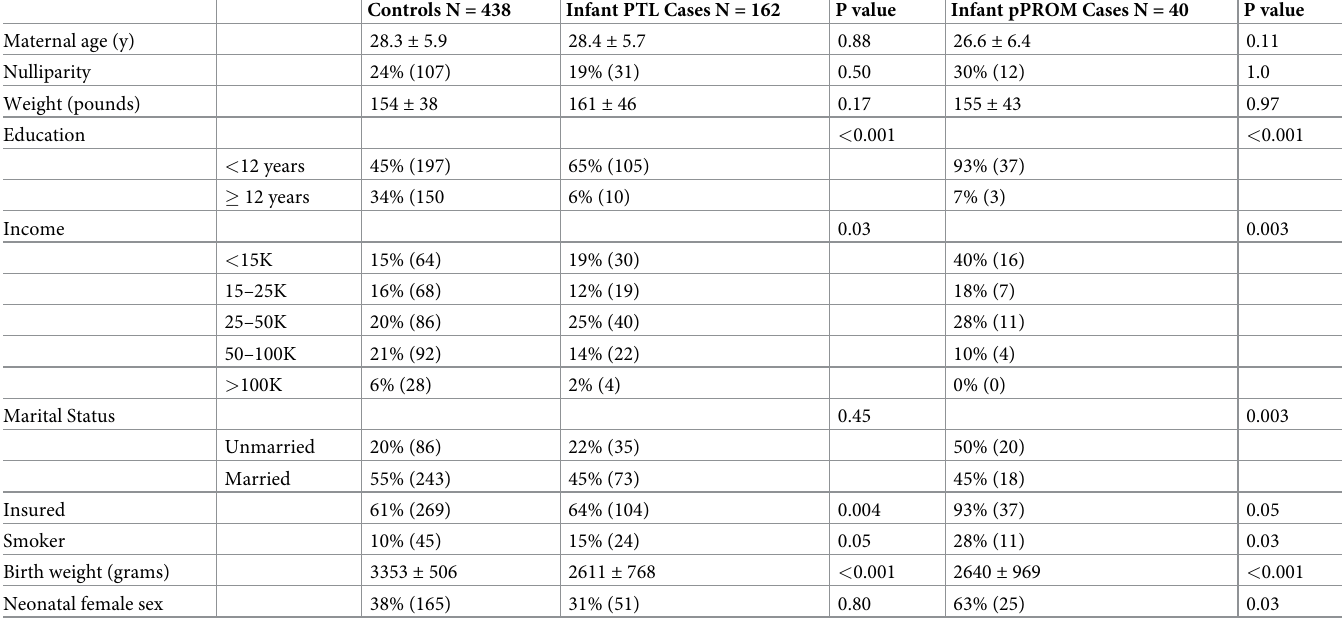
Table 3. Baseline characteristics of fetal cases and